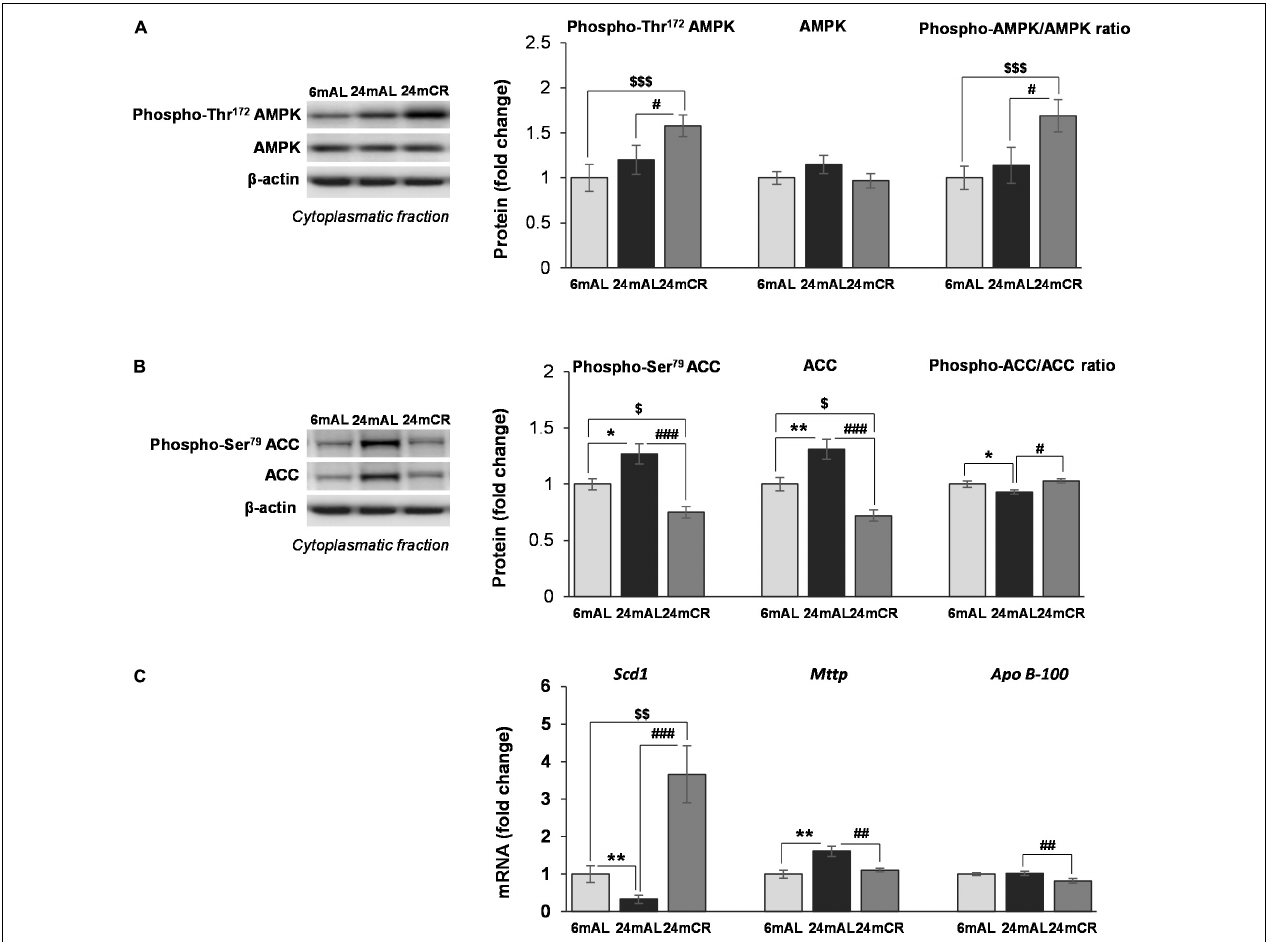
FIGURE 1 | The levels of phosphorylated and total AMPK and ACC proteins and other mediators of lipid synthesis in the liver. Representative Western blots and relative quantification of phospho (Thr172) and total AMPK (A) and phospho (Ser79) and total ACC (B) in the cytoplasmatic fraction of the liver of adults (6 mAL), aged rats on AL diet (24 mAL), and old rats on CR (24 mCR). β -Actin was used as the loading control for cytoplasmatic fraction. Quantification of Scd1 , Mttp , and Apo B-100 mRNA levels (C) in the liver was done relative to the amount of β -actin. All values are given as means ± SEM ( n = 8). Asterisk indicates a significant difference between aged rats on AL diet and adults (24 mAL vs. 6 mAL, * p < 0.05, ** p < 0.01), hashtag indicates a difference between old rats on different diet regimes (24 mCR vs. 24 mAL, # p < 0.05, ## p < 0.01, ### p < 0.001), and symbol $ denotes a difference between old rats on CR and adults fed AL (24 mCR vs. 6 mAL, $ p < 0.05, $$ p < 0.01, $$$ p <